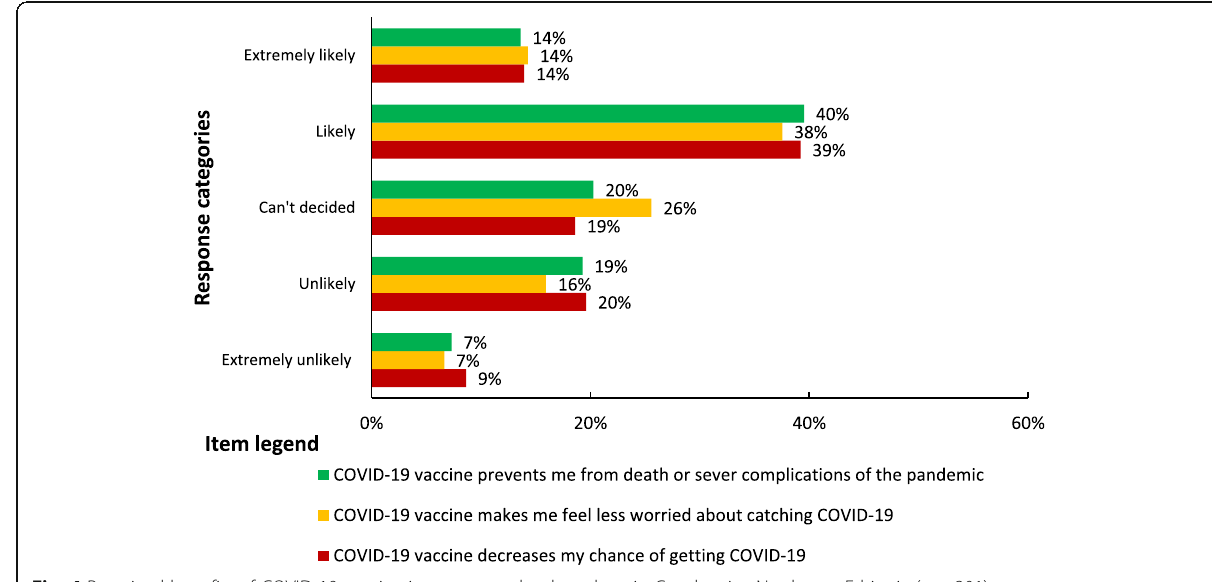
Fig. 4 Perceived benefits of COVID-19 vaccination among school teachers in Gondar city, Northwest Ethiopia (n =